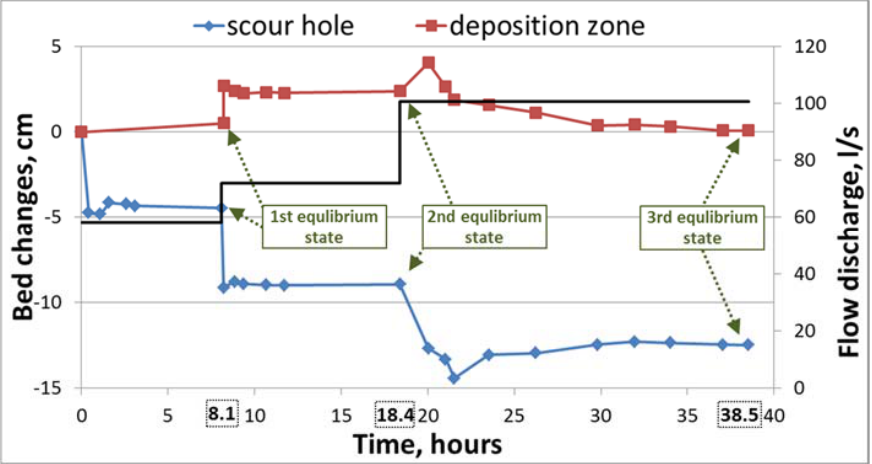
Figure 4. The bed change time series in the deposition zone (red line and dots) and in the scour hole (blue line and dots). The discharge time series is also visualized by the black solid line.